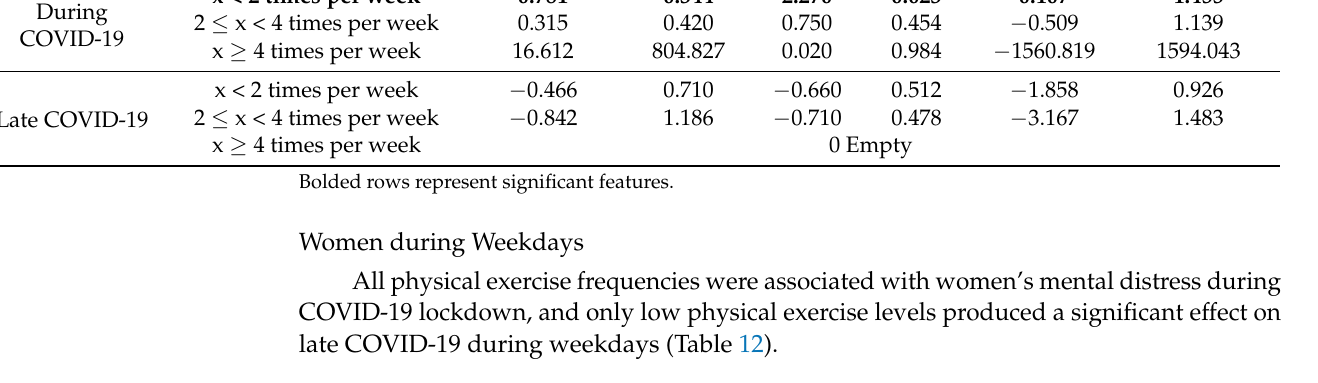
Table 12. The effect of the COVID-19 era and physical exercise frequency on mental distress in women during